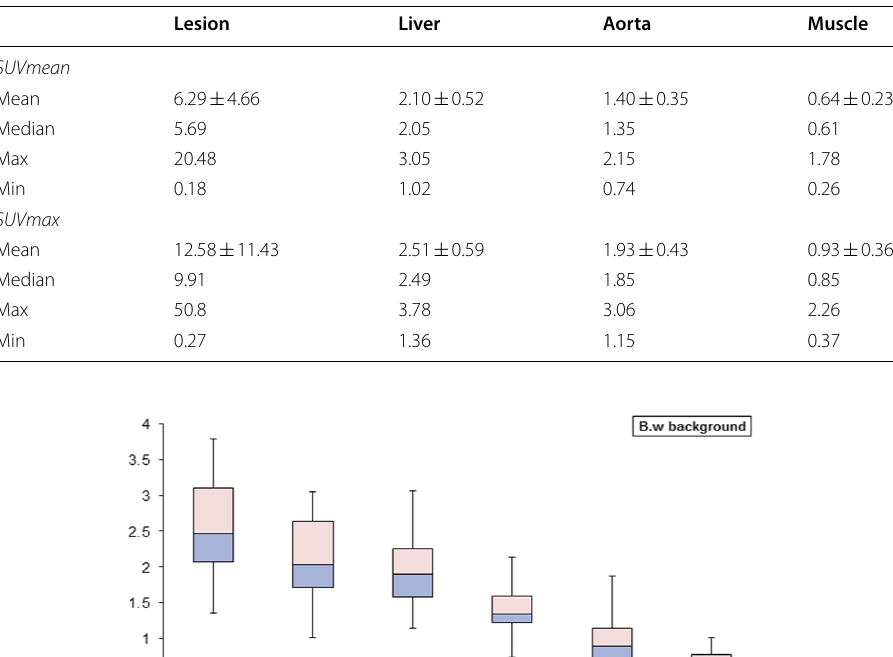
Table 2 Statistical descriptions of patients SUVmax, SUVmean including tumor lesions, liver, aorta, and muscle tissues